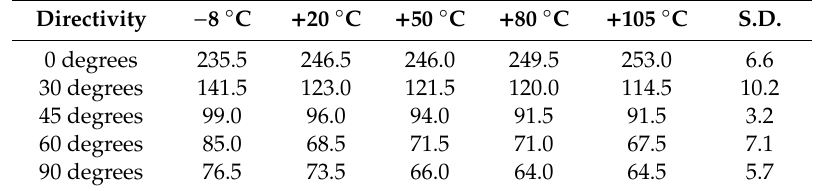
Table 3. Variation of the first resonance frequency according to different temperature conditions (Unit: Hz).